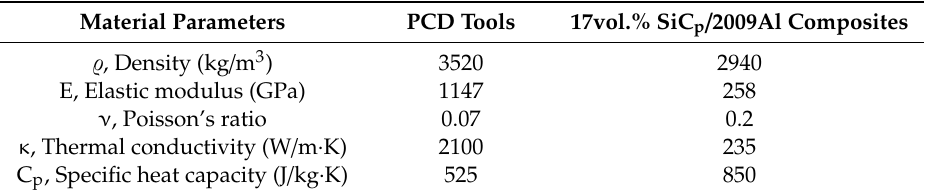
Figure 1. Finite element model of SiC p / Al composites. Table 1. Material properties of 17vol.% SiC p /2009Al composites and polycrystalline diamond (PCD) tool [24,25].